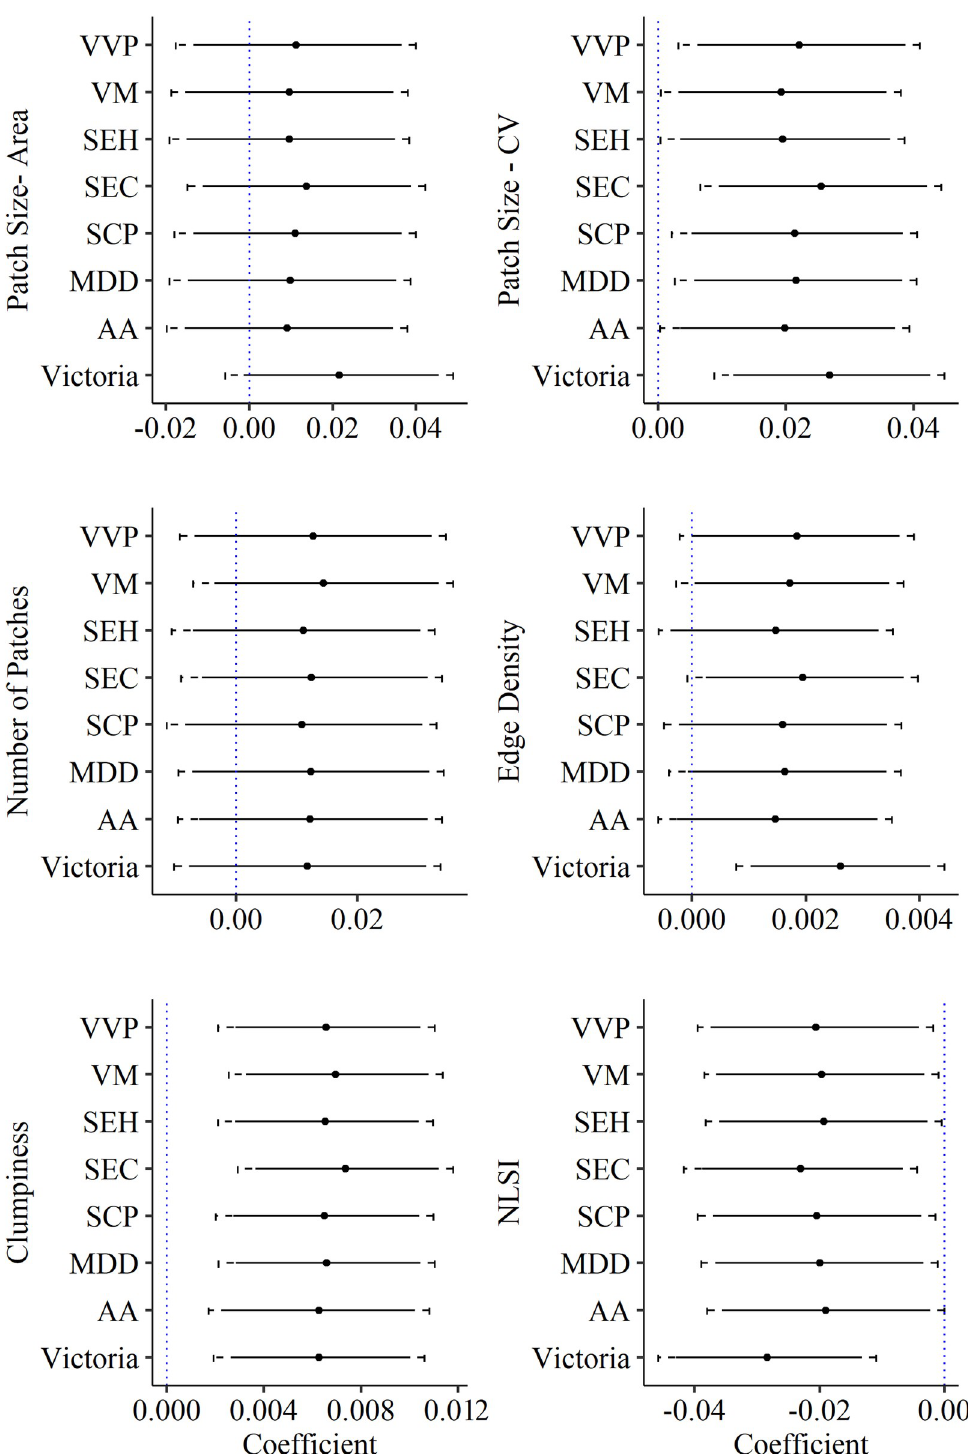
Fig 5. Estimated coefficients for high-severity spatial metrics by bioregions. Each panel displays results for a single model for all regions (“Victoria”) and for individual bioregions (Acronyms of bioregions are defined in Table 1); Dot points represent mean estimated coefficient along with the 90th (solid line) and 95th (dashed line) percentile intervals. Coefficients denote significant changes when interval does not include zero. Spatial metrics were log transformed (Number of Patches, Mean Patch Area, Variation Patch Area, NLSI) or arcsine transformed (Edge Density).